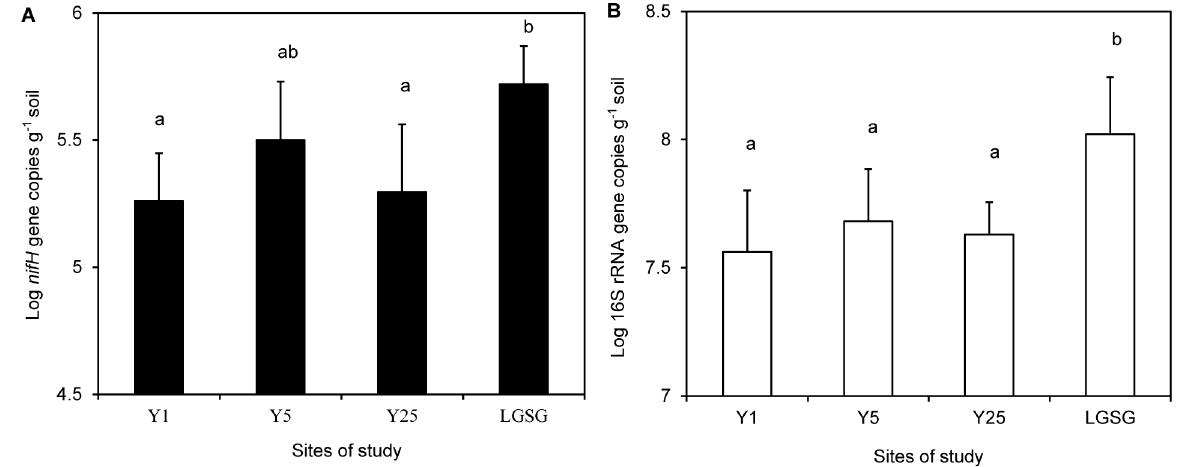
Figure 3. Copy numbers of the nifH (A) and 16S rRNA (B) genes. Results of analysis of variance (ANOVA) in the abandoned cropland (Y1, Y5, and Y25) and light-grazing steppe grassland (LGSG) soils (n=5; error bars represent standard deviations). Significant differences are indicated by different letters.